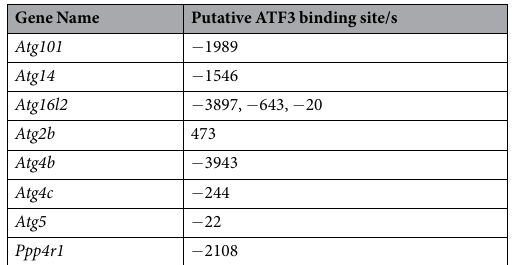
Table 4. Location of the putative ATF3 binding sequence in the promoter region of the various autophagy- related genes. The − 5 kb to + 1 kb region of the gene containing the putative promoter elements was scanned for